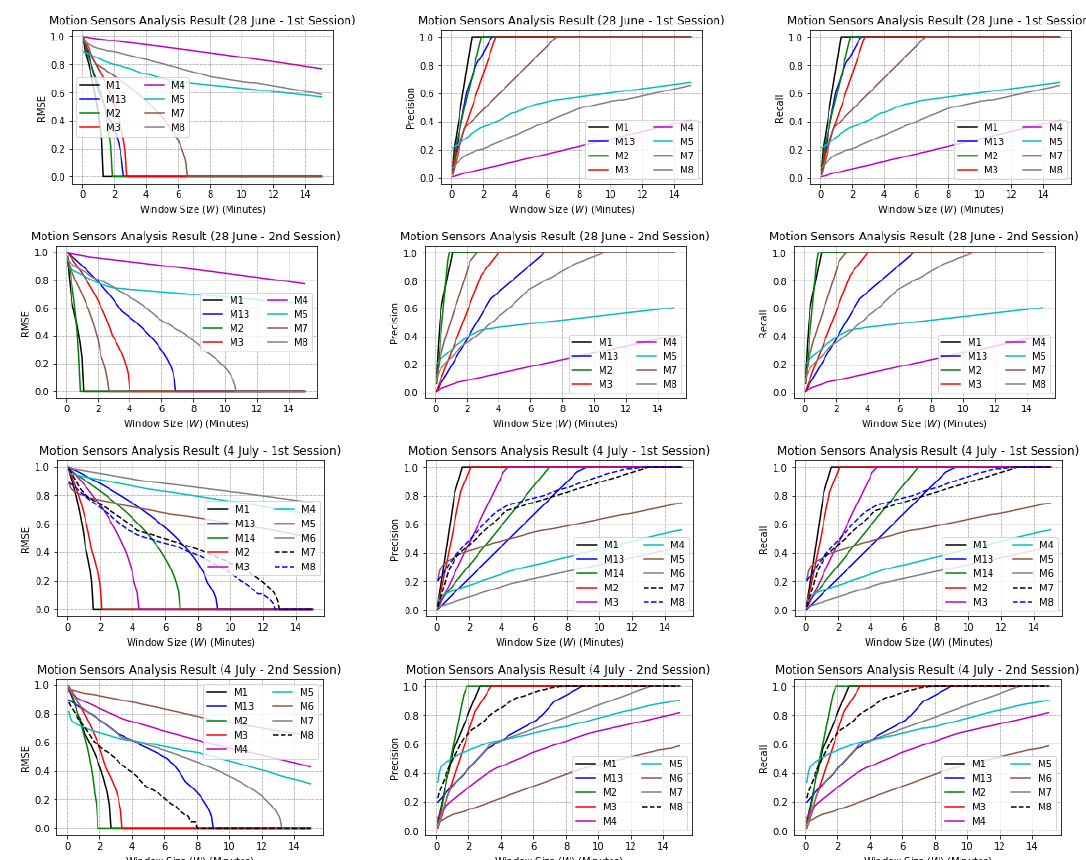
Figure A1. TSR analysis: (left column) RMSE value, (middle column) precision score, and (right column) recall score of motion sensors (shown in different colors) for different window sizes in each